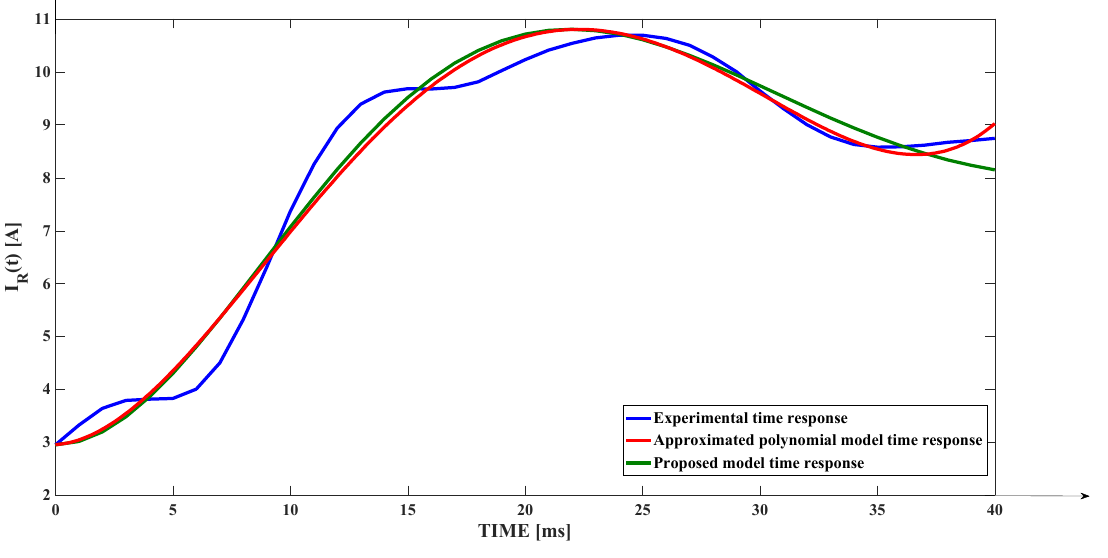
Figure 10. Comparative graph between the experimental response I R (t), the approximate polynomial model response, and the mathematical model of the second-order response.